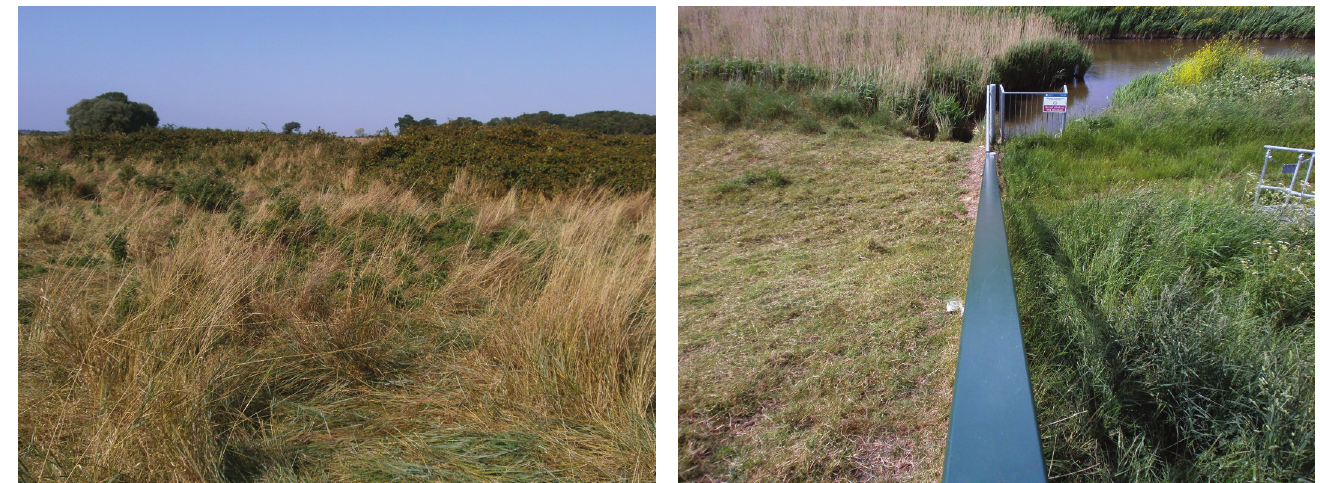
Fig. 7. Uncut grassland and scrub on a sea wall folding (Bright- lingsea, Essex, UK); credit T. Gardiner.